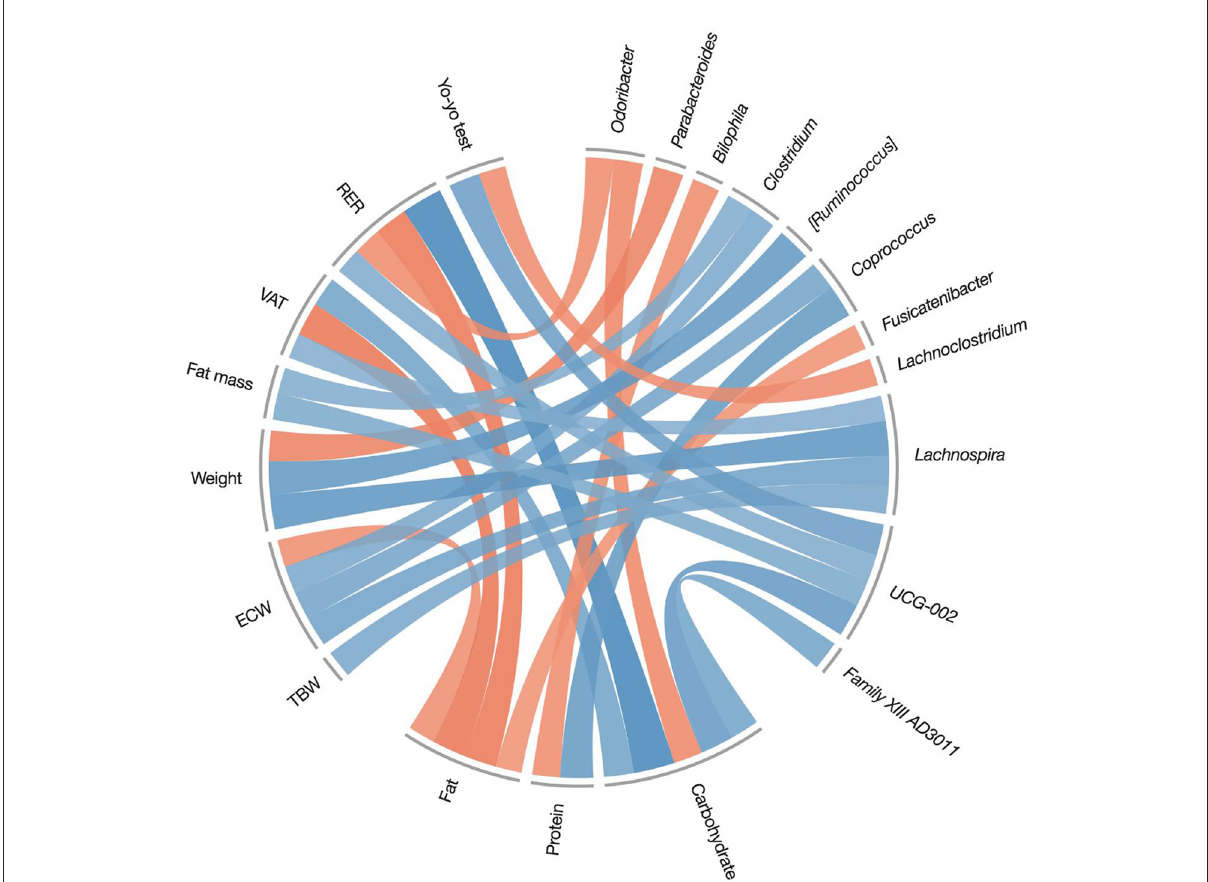
FIGURE5 Spearman’s correlations between macronutrient intake during the treatment period (7 days food-diary), and post-pre variations on body composition measures, fitness measures, and genera relative abundances. Only significant correlations were reported ( r 0.05,14 ≥ 0.503). Positive correlations are represented by blue color and negative correlations by red color. TBW, total body water; ECW, extracellular water; VAT, visceral adipose tissue; RER, respiratory exchange